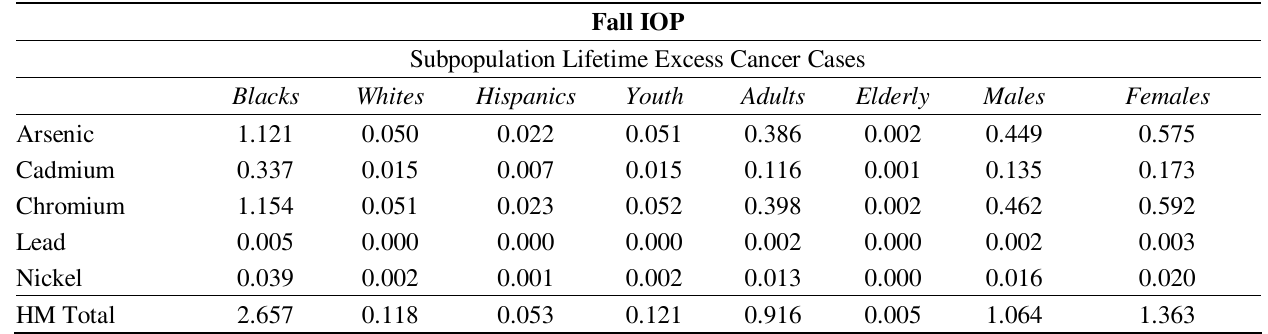
Table 6: Fall IOP Lifetime Excess Lung Cancer Cases by DC